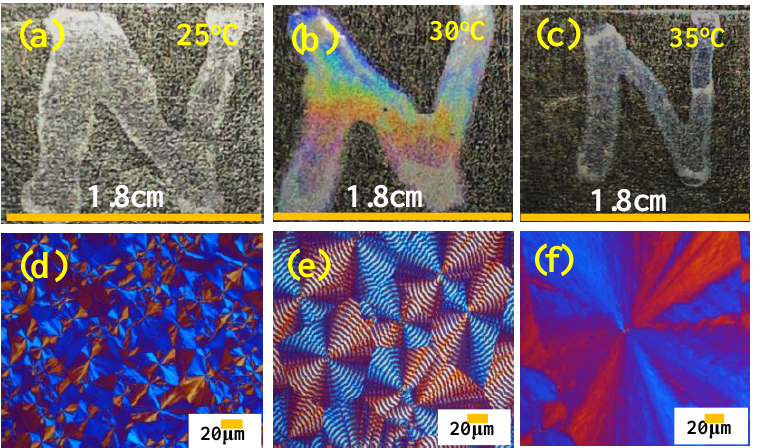
Figure 13. Photonic iridescence of specimens hand-stenciled into a letter "N" and crystallized at var- ious T c 's: ( a ) small-size ringless PBA (T c = 25 °C), ( b ) medium-size regularly ring-banded PBA (T c = 30 °C), ( c ) large-size dendritic PBA aggregates (T c = 35 °C), and ( d – f ) POM micrographs of corre- sponding specimens cast into "N" letter from PBA/PEO (90/10) blend.